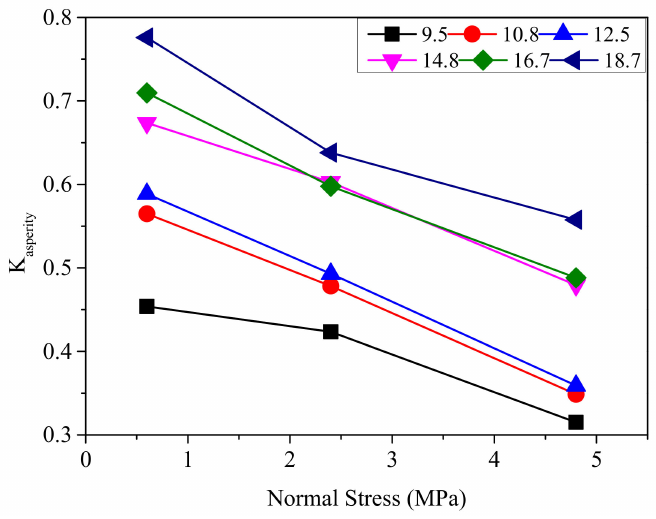
Figure 12. Mechanical contribution of asperity to the shear strength of the joint